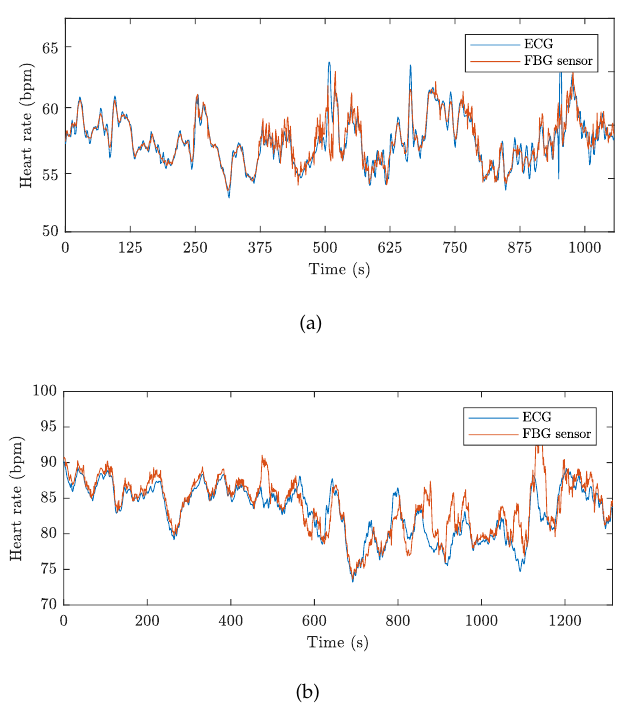
Figure 14. The full-time course of cardiac activity over the conducted MRI examinations: ( a ) volunteer M1, and ( b ) volunteer F1.